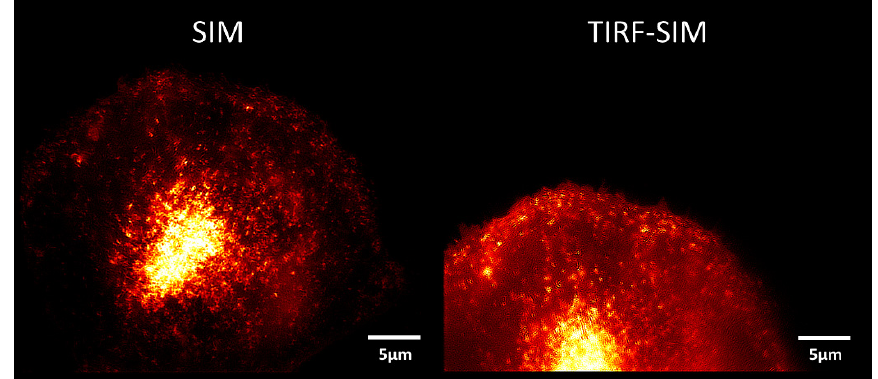
Figure 2. Condenser for TIR illumination under variable angle (schematic, ( a )); TIRFM image of CHO cells expressing a membrane-associated green Fluorescent Protein (GFP) recorded at Θ = 66° ( b ); cell-substrate distances in the range of 0–400 nm calculated from VA-TIRFM according to Equation (1) and shown by color code ( c ) (excitation wavelength: 476 nm, detection range: λ ≥ 490 nm; scale bar: 20 µ m).